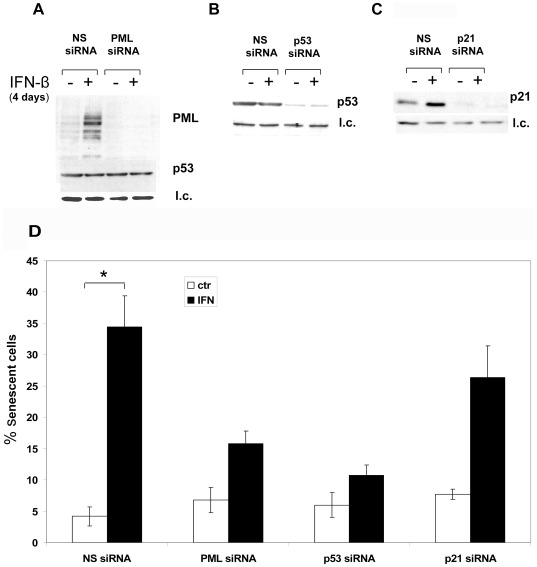
Effect of PML, p53 and p21 silencing on senescence induction by IFN-β in K38 cells.PML (A), p53 (B) and p21 (C) were silenced by specific small interfering RNAs and protein expression was analyzed by Western blot in cells treated with IFN-β for 4 days. (D) Senescence induction by IFN-β (4 days treatment) was evaluated by SA-βgal staining. * = p<0.05; ** = p<0.01.